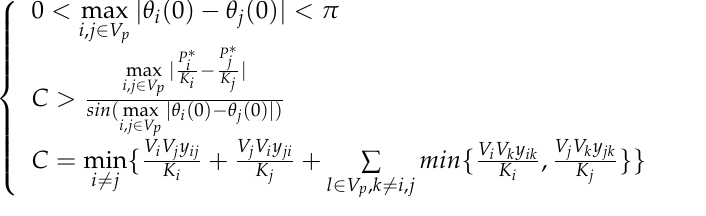
Table 1. Correspondence between the parameters of the physical layer microgrid model and the Kuramoto model. Kuramoto Physical Layer ξ